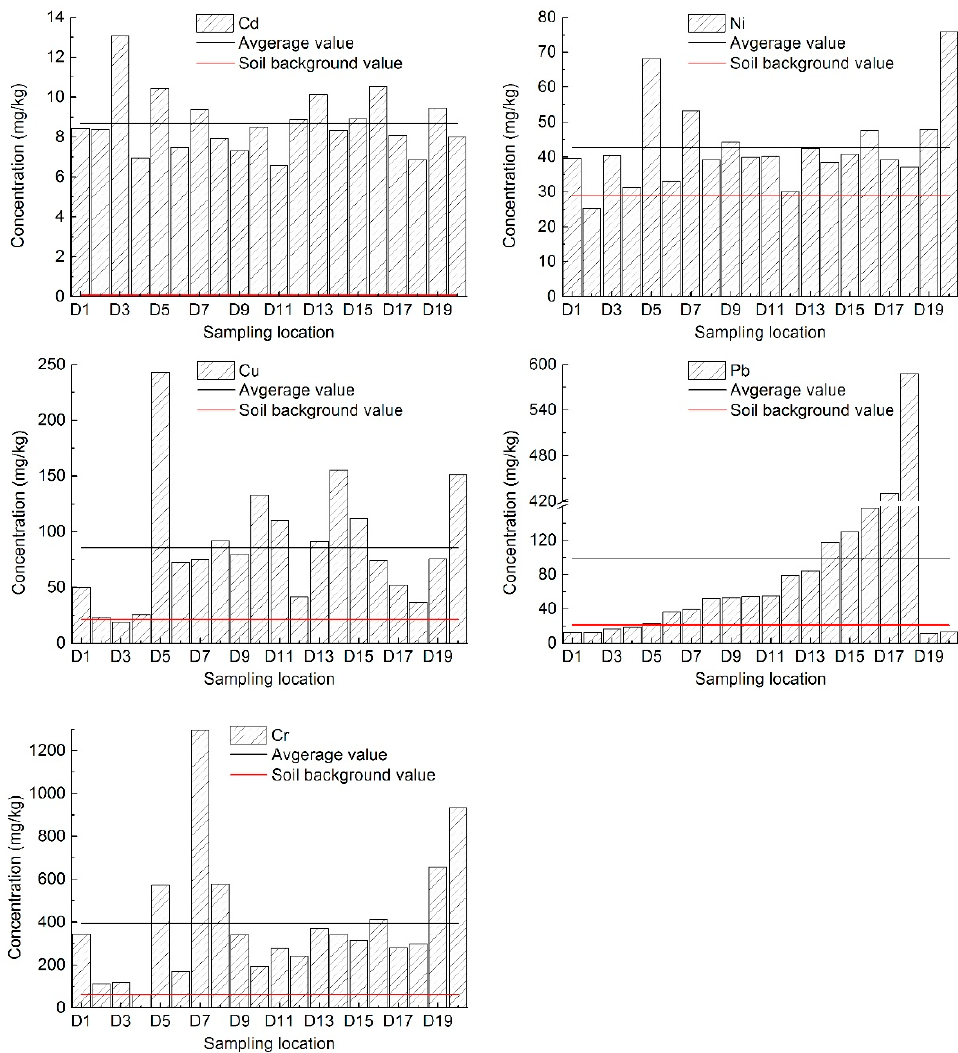
Figure 1. Heavy metal contents in dust in leisure squares of Yanta District of Xi’an.